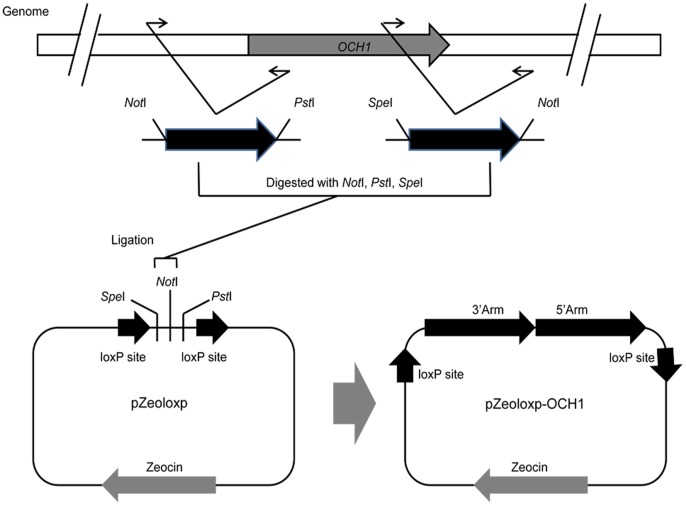
Schematic representation of the construction of the disruption plasmid.The OCH1 gene was used as an illustrative example. Upstream and downstream homologous regions of OCH1 were initially amplified by polymerase chain reaction from Pichia pastoris GS115 strain with two primer pairs. The two fragments were cut using SpeI, NotI, and PstI, as well as ligated into pZeoloxp by performing a three-fragment ligation, thereby generating pZeoloxp-OCH1, which is the disruption plasmid for the OCH1 gene.